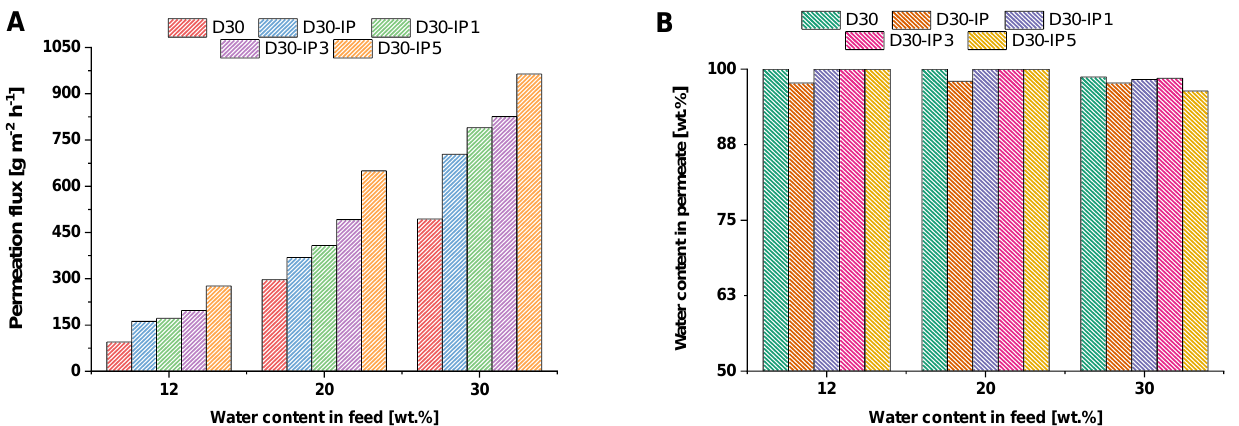
Figure 9. Pervaporation performance of TFC and TFN membranes with ChS-Fe-BTC interlayer: ( A )—permeation flux; ( B )—water content in permeate. It was shown that when 30 wt % Fe-BTC was embedded into the ChS selective